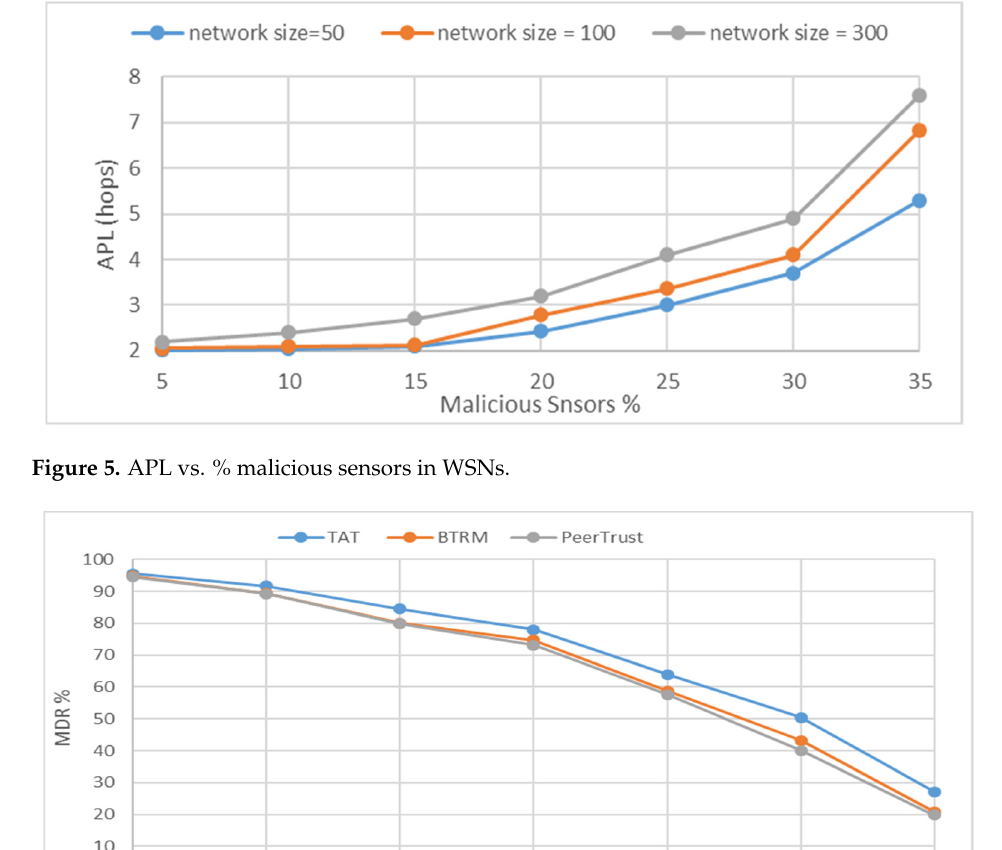
Table 2. Total AEC (µJ) in the network.